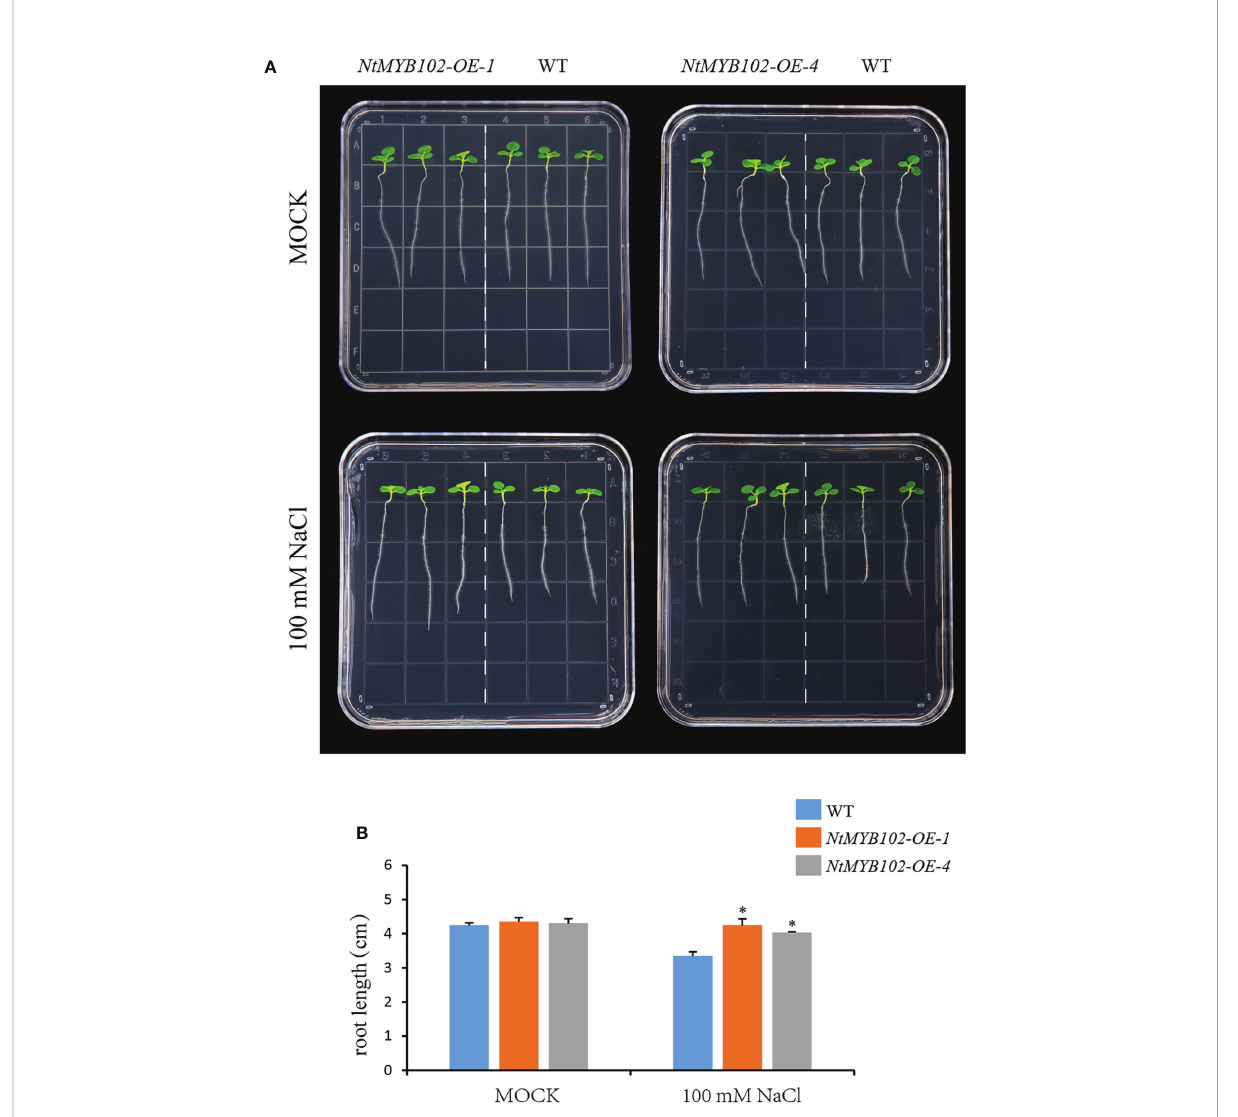
FIGURE 8 The function of NtMYB102 in plant salt tolerance. (A) Root growth of wild-type and NtMYB102 overexpression lines under 0 or 100 mM NaCl treatment. (B) The quanti fi cation of primary root length on medium and the data were retrieved from more than 15 plants per genotype with three biological replicates. WT, wild-type. Values represent means ± SD. *p < 0.05 ( t